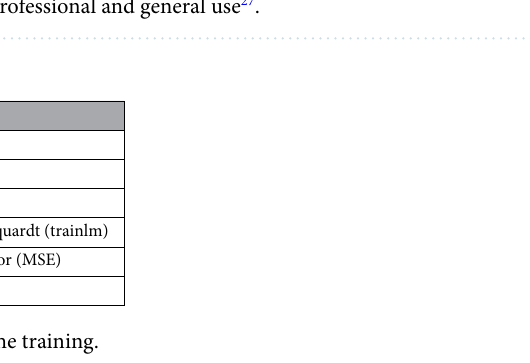
Table 2. Classification of EM SE values on professional and general use 27 .